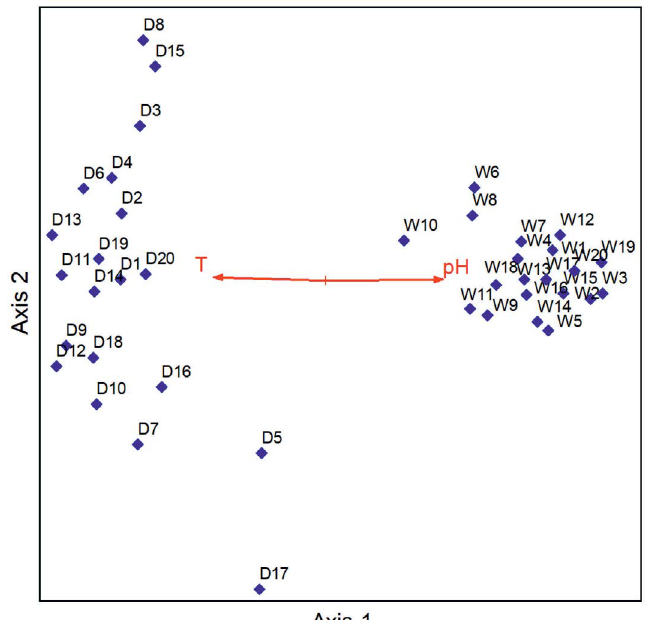
Fig. 5. NMS result of human pathogenic bacteria illustrating a Biplot overlaid with physical factors (D=Dry season samples, W=Wet season